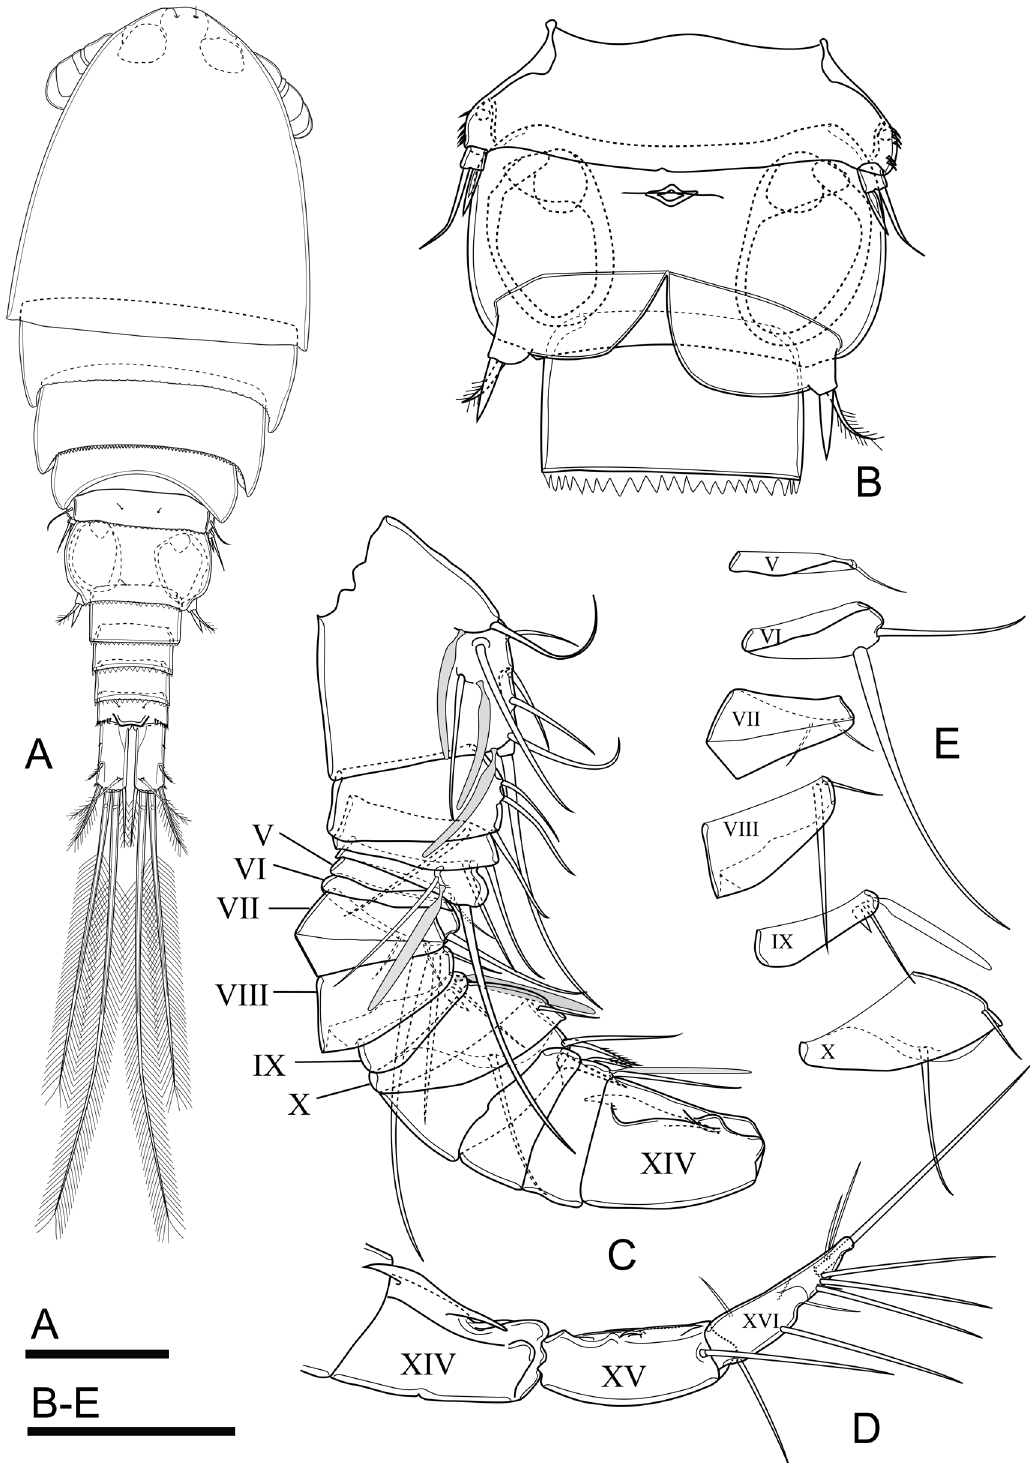
Fig. 14. Metacyclops brancelji sp. nov., paratype, ♂ (A; ZMB 34231 slide No. 5126), allotype, ♂ (B−C, E; ZMB 34231 slide No. 5125) and additional material, ♂ (D; ZMB 34231 slide No. 5129). A . Habitus, dorsal view. B . Genital and first abdominal somites, ventral view. C . First to fourteenth segment of antennule. D . Fourteenth to sixteenth segment of antennule, E . Fifth to tenth segment of antennule (Roman numerals indicate segment of antennule). Scale bars: A = 100 μm; B−E = 50